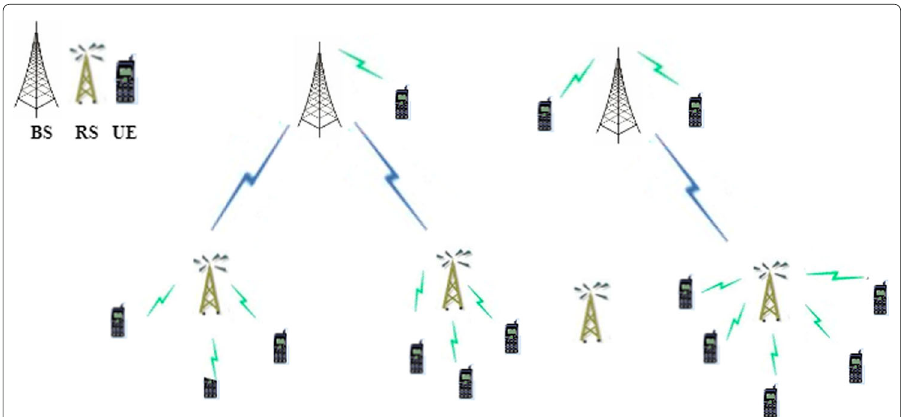
Fig. 2 Planning capacity model for the formulated wireless